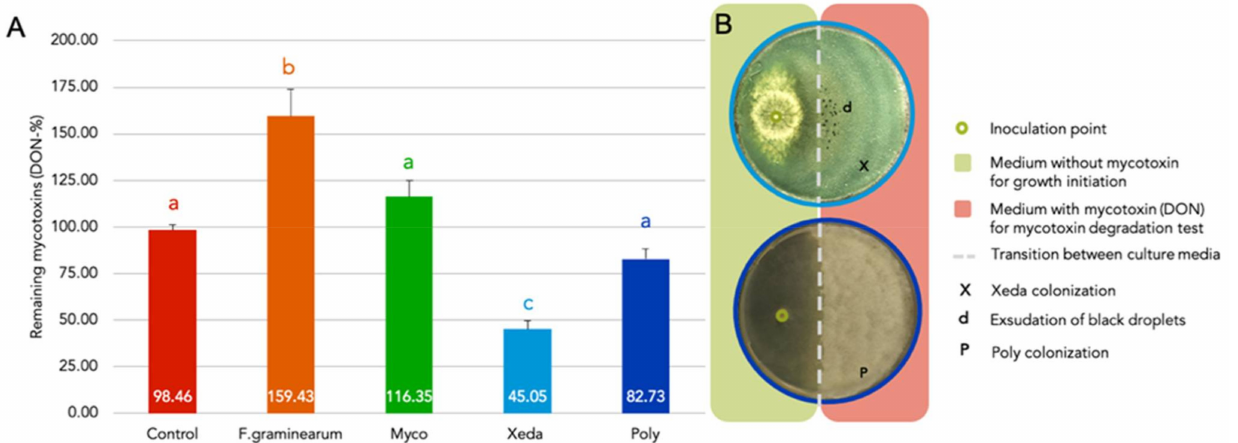
Figure 8. BCAs biotransformation of mycotoxin (DON). ( A ) Remaining mycotoxin of F. graminearum (DON) in CYA medium (whole dish extraction), 15,000 ng.g-1 of media = 100%, after 12 days of growth of BCAs at 25 ◦ C. Control corresponded to Petri dish without inoculation of microorganisms. ( B ) Dispositive and visual aspect of Xeda and Poly colonization during biotransformation test. Myco: Mycostop ® , Xeda: Xedavir ® , Poly: Polyversum ® . ANOVA test, p -value <